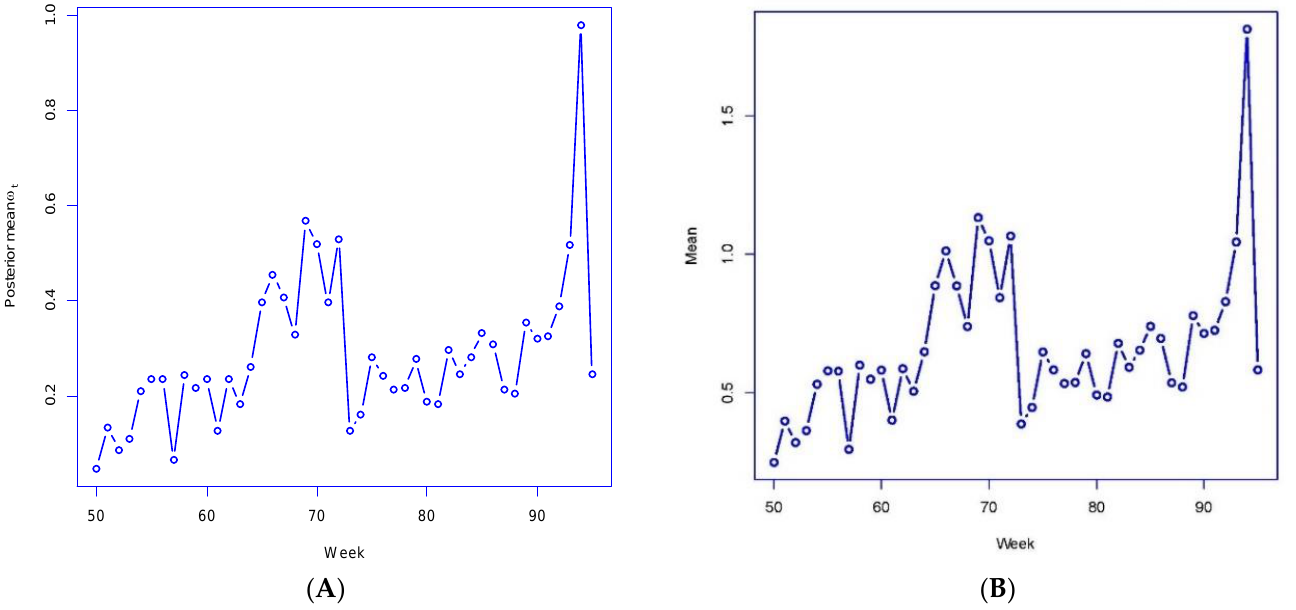
Figure 3A,B plot out the posterior mean ω t under M4 for weeks 50–95 and the averages ρ of the ρ it . For these weeks, the ω t and ρ correlate highly (over 0.99) with actual growth rates in London-wide total cases Y t / Y t − 1 , emphasizing how well the parameters reproduce the actual infection data. For 6 of these 45 weeks, the London-wide 𝜌 𝑡 under M4 has a posterior mean exceeding 1 (i.e., rapid case growth in epidemic periods), with the highest 𝜌 𝑡 being 1.81 for week 94. These results confirm the utility of the link-mixture mechanism in reproducing actual infection count fluctuations. Figure 3A Posterior Mean Omega, London Boroughs